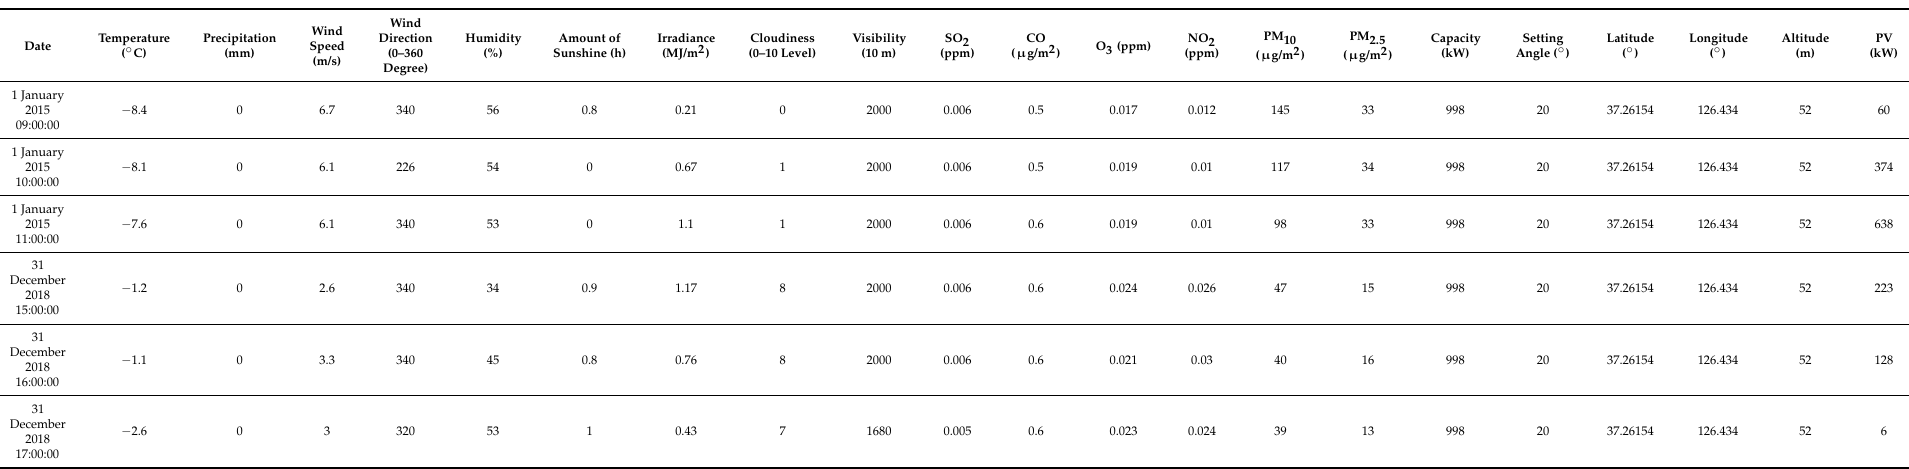
Table 3. The sample of the numerical